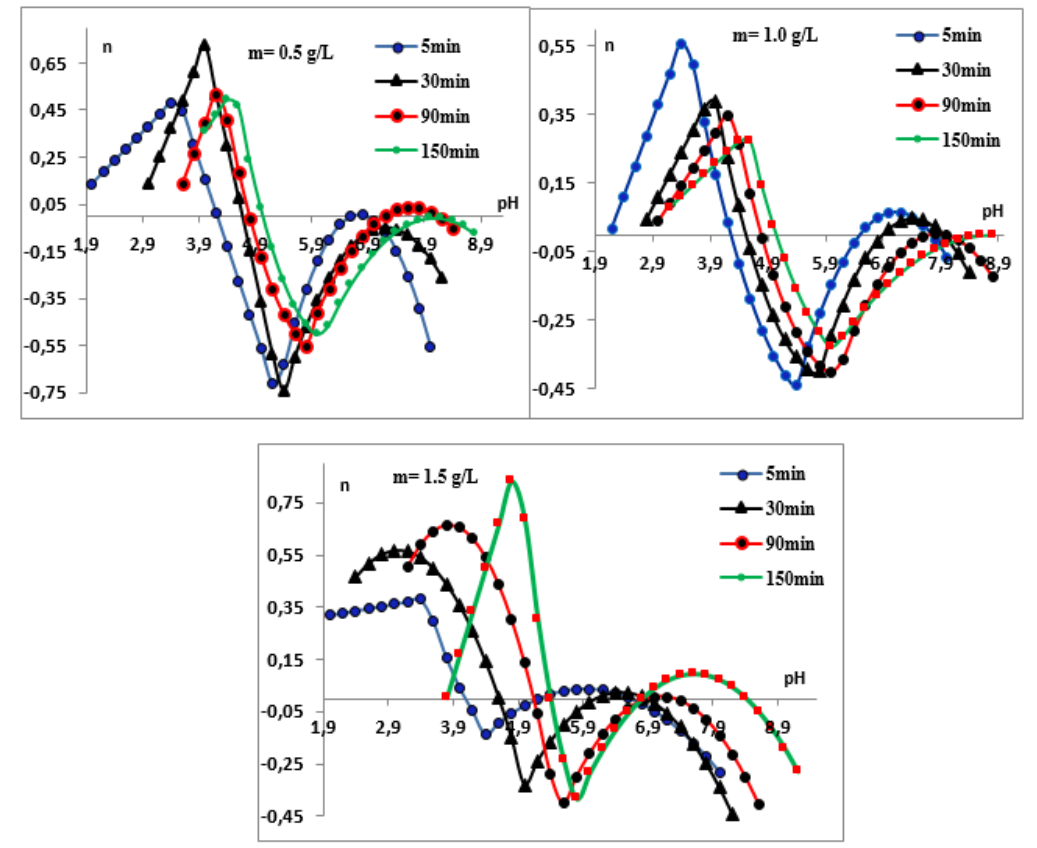
Figure 2. Variation of n = f(pH) obtained at various contact time and at different OCP sorbent amounts of m = 0.5, 1.0 and 1.5 g/L: 5 min (●); 30 min ( ▲ ); 90 min (●); and 150 min ( ■ ).